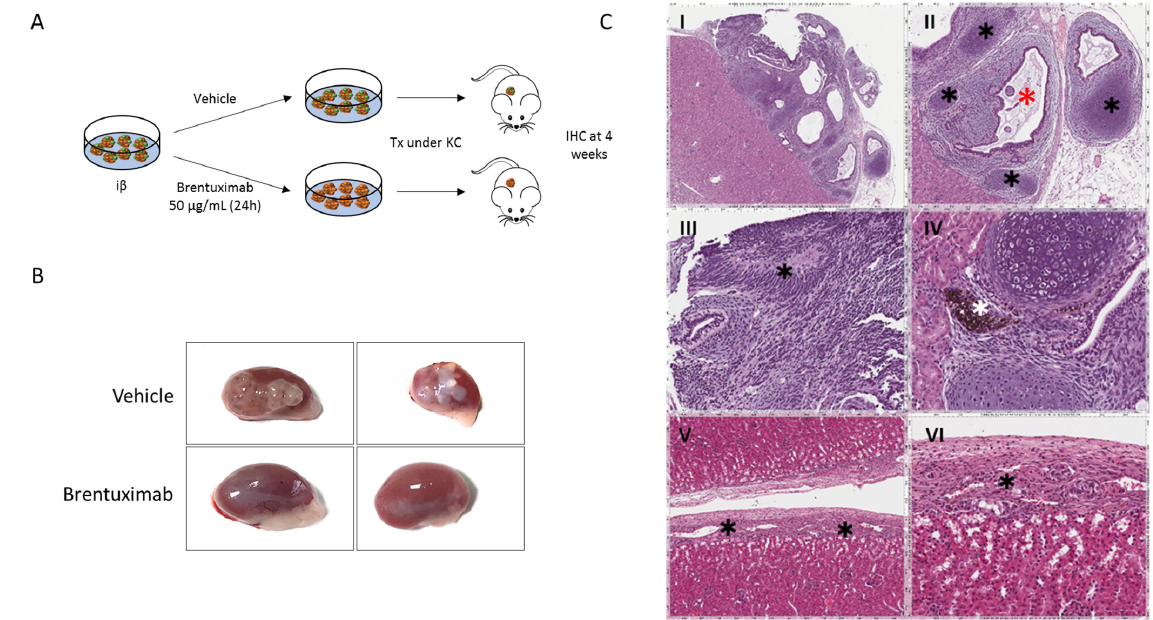
Figure 3. Effect of Brentuximab vedotin pretreatment on i β s 4 weeks after transplantation. ( A ). Schematic representation of i β pretreatment with vehicle or BRE and transplantation under the kidney capsule. ( B ). Gross pathology of kidneys explanted 4 weeks after transplant of i β s treated with vehicle (upper images) or BRE (lower images). ( C ). Hematoxilin and Eosin stain of grafts explanted 4 weeks after i β transplantation: mice not pretreated with BRE developed teratoma at the graft site (I). Islands of condroid tissue (black asterisks, panel II), glandular structures (red asterisk, panel II) immersed in an immature mesenchymal tissue, rosette-forming neuroepithelium (black asterisk, panel III) or pigmented retinal-type epithelium (white asterisk, panel IV) were observed. In mice pretreated with BRE, no tumor developed. Endocrine islet-type cells can be seen in the renal capsule (V and VI).